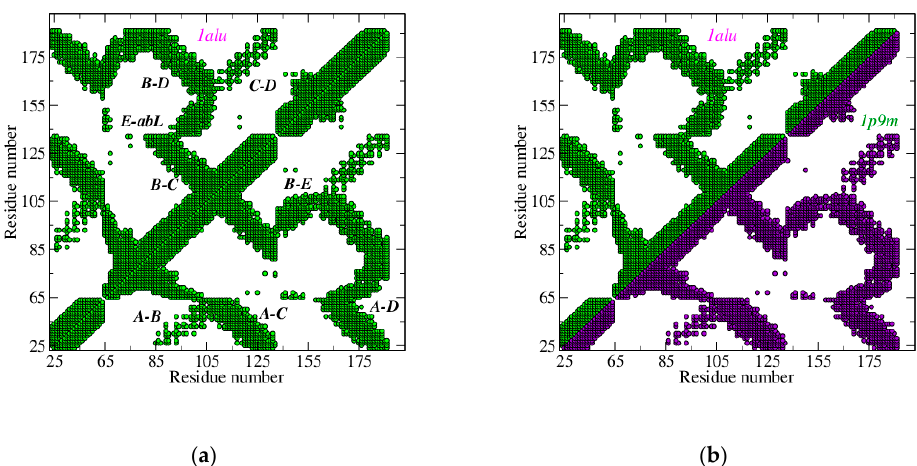
Figure 2. Contact maps of IL-6, in: ( a ) the native state (PDB ID: 1alu [45]) and ( b ) the active state due to the conjugation with natural receptors IL-6R and gp130 (PDB ID:1p9m [41]), D = 15 Å. ( a ) The intra-contacts among helices A, B, C, D, and E are highlighted, and abL indicates the loop between helices A and B; ( b ) IL-6 in the native state (green) is reported vs. IL-6 in the active state (violet).